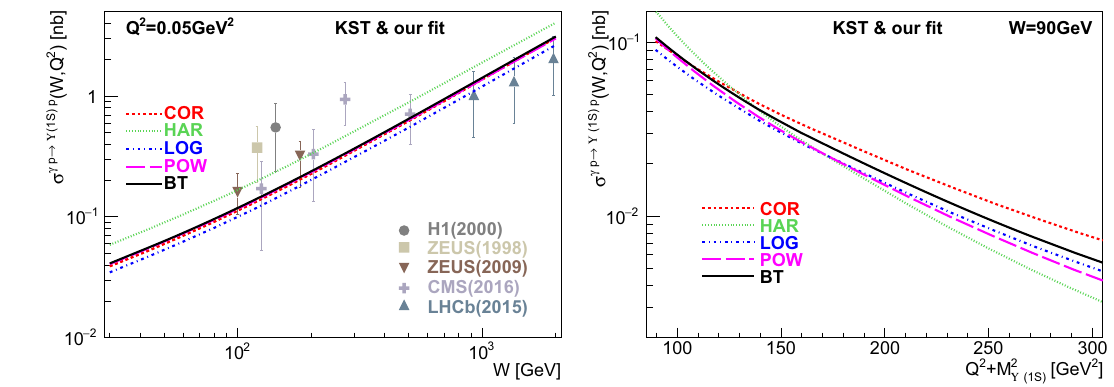
Fig. 13 The same as Fig. 8 but for different realistic b − ¯ b interaction potentials as described in Appendix